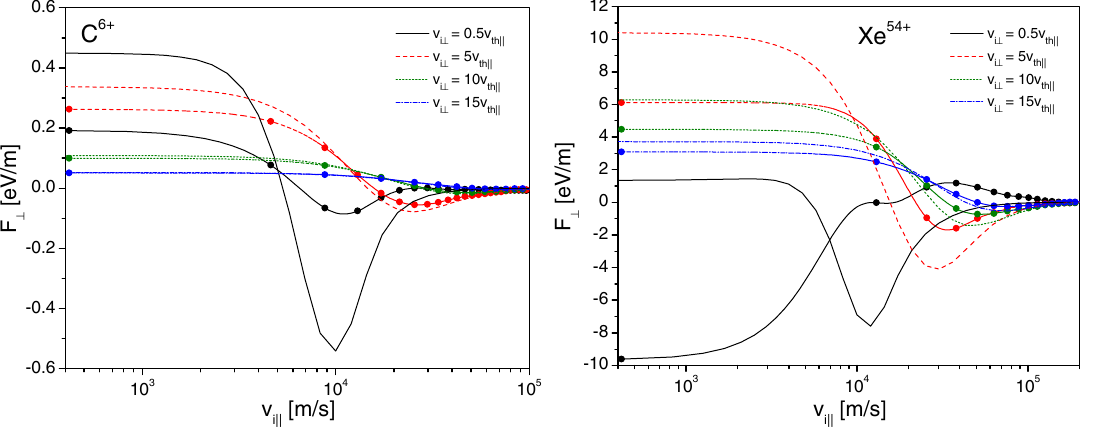
FIG. 7. Same as in the left panels of Figs. 5 and 6 for C 6 þ and Xe 54 þ ions, respectively, but for the transverse force (cid:1) F ?